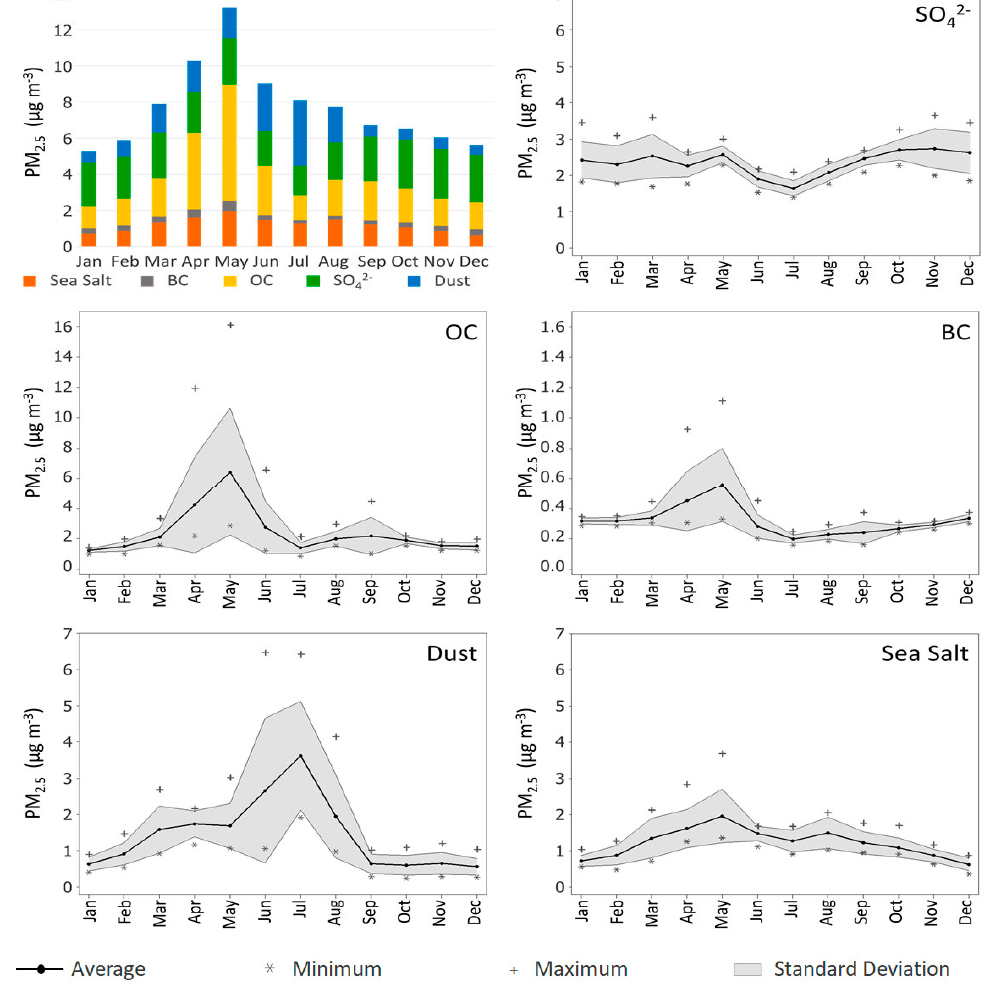
Figure 6. Annual PM 2.5 profile from MERRA-2 over the MMA from January 2010 to December 2014. Upper left panel: annual profiles of all PM 2.5 components. Upper right panel and lower panels: annual PM 2.5 profile by component.